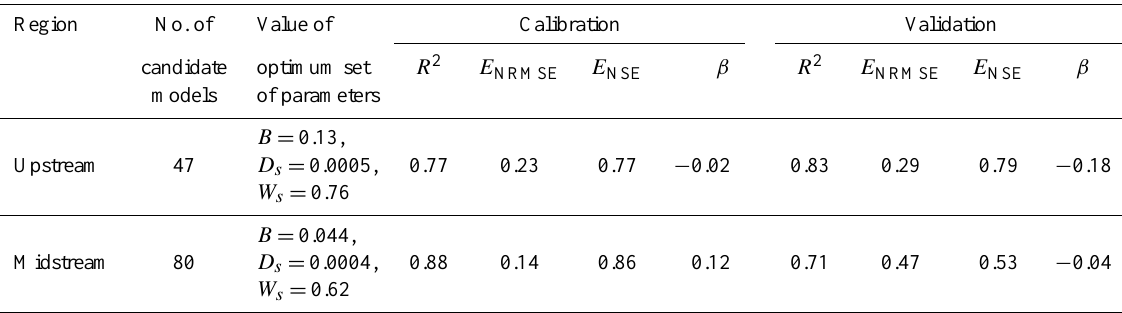
Table 2. Structure of the VIC model obtained for upstream and midstream regions along with the performance measures during calibration and validation phase. Region No. of Value of Calibration Validation candidate optimum set R 2 E NRMSE E NSE β E NSE β models of parameters B = 0.13, Upstream 47 0.77 W s = 0.76